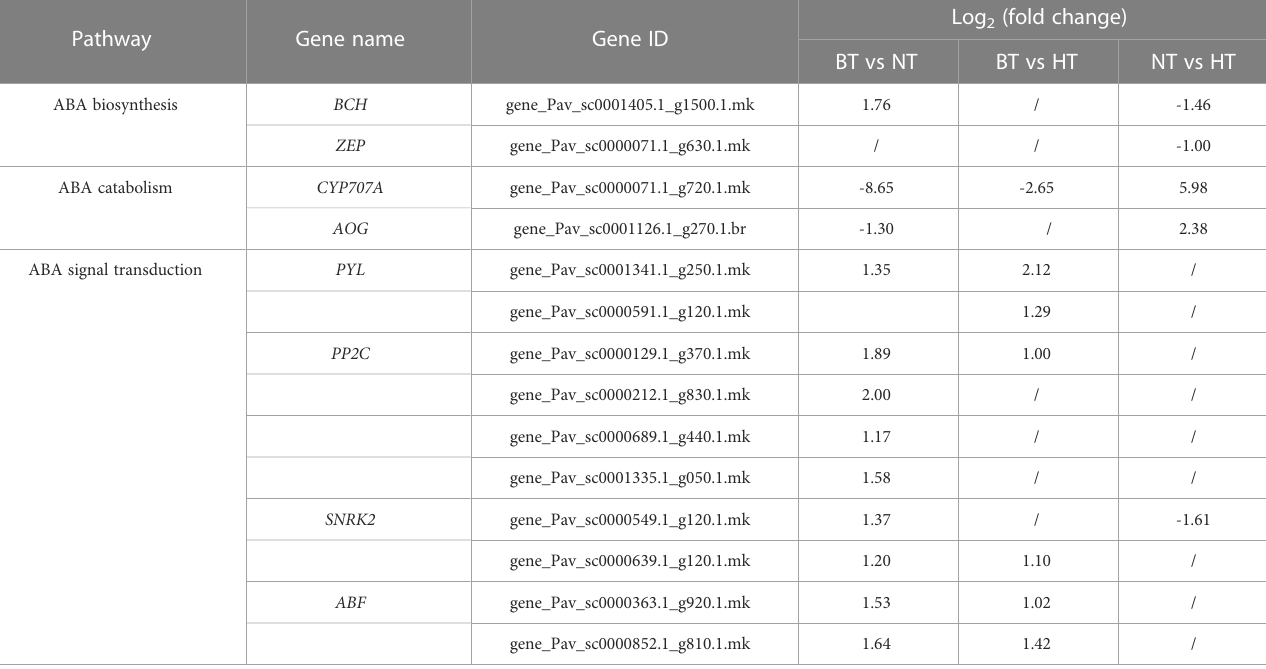
TABLE 2 Expression of DEGs involved in the biosynthesis, catabolism and signal transduction of plant